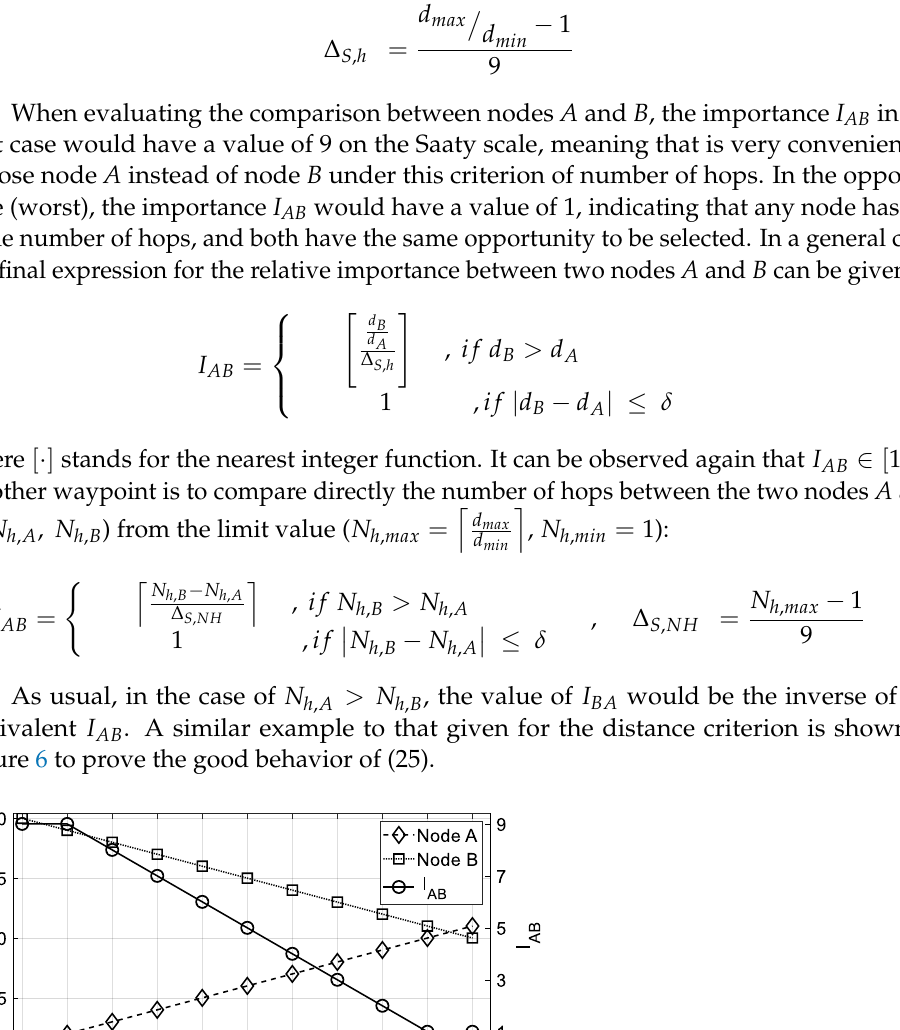
Figure 5. Importance value I AB (circles) when nodes A and B are compared under the distance crite- rion. Data: d max = 10 km, d min = 0.5 km, 𝛿 = 1.